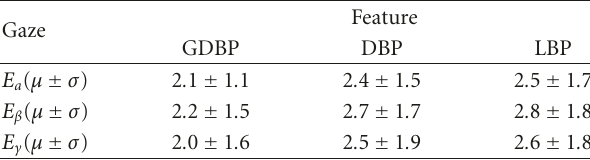
Table 3: Errors of three gaze directions (degree).